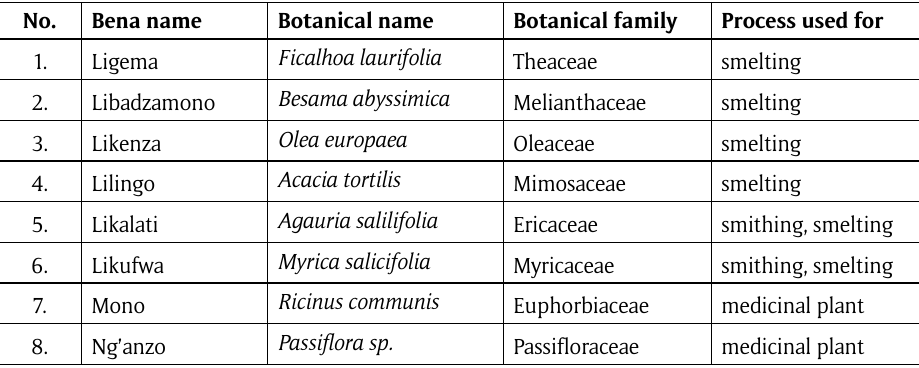
Table 2: The Mjimwema bio-archaeometallurgical species for